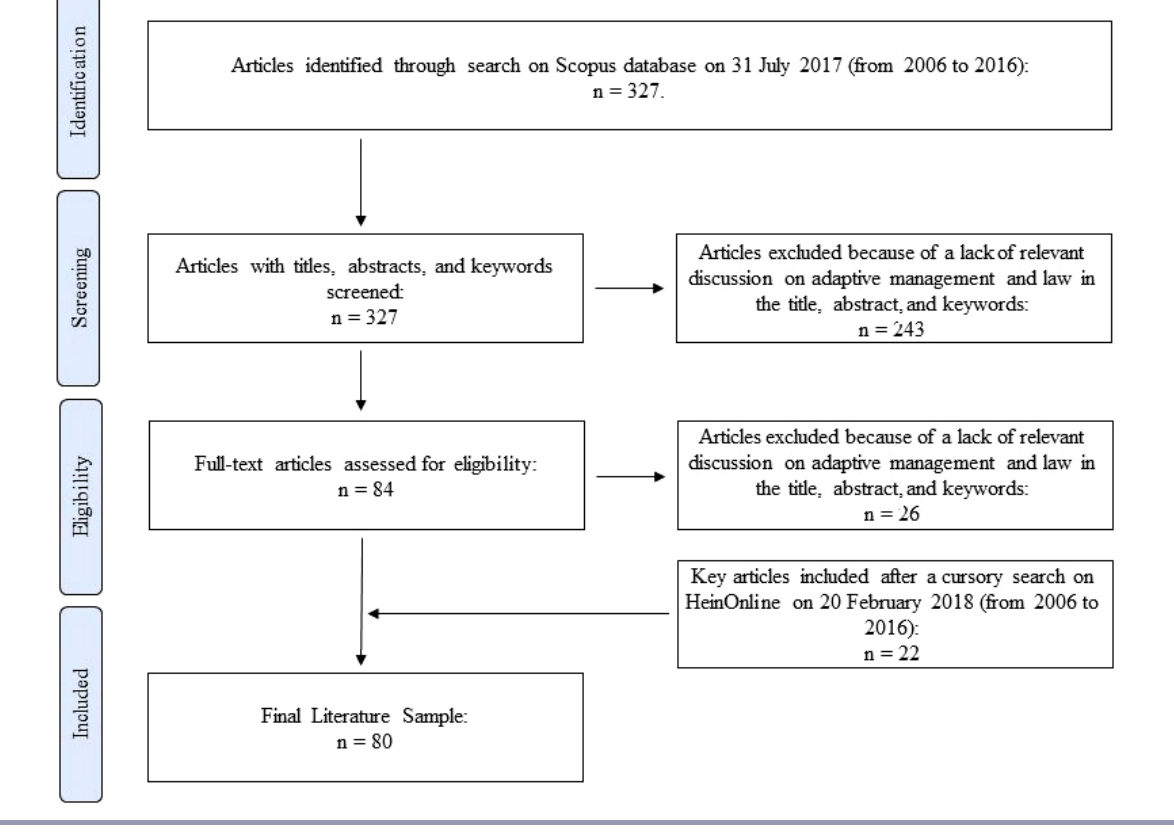
Fig. 1 . Flowchart outlining the protocol adopted in this systematic review based on the Preferred